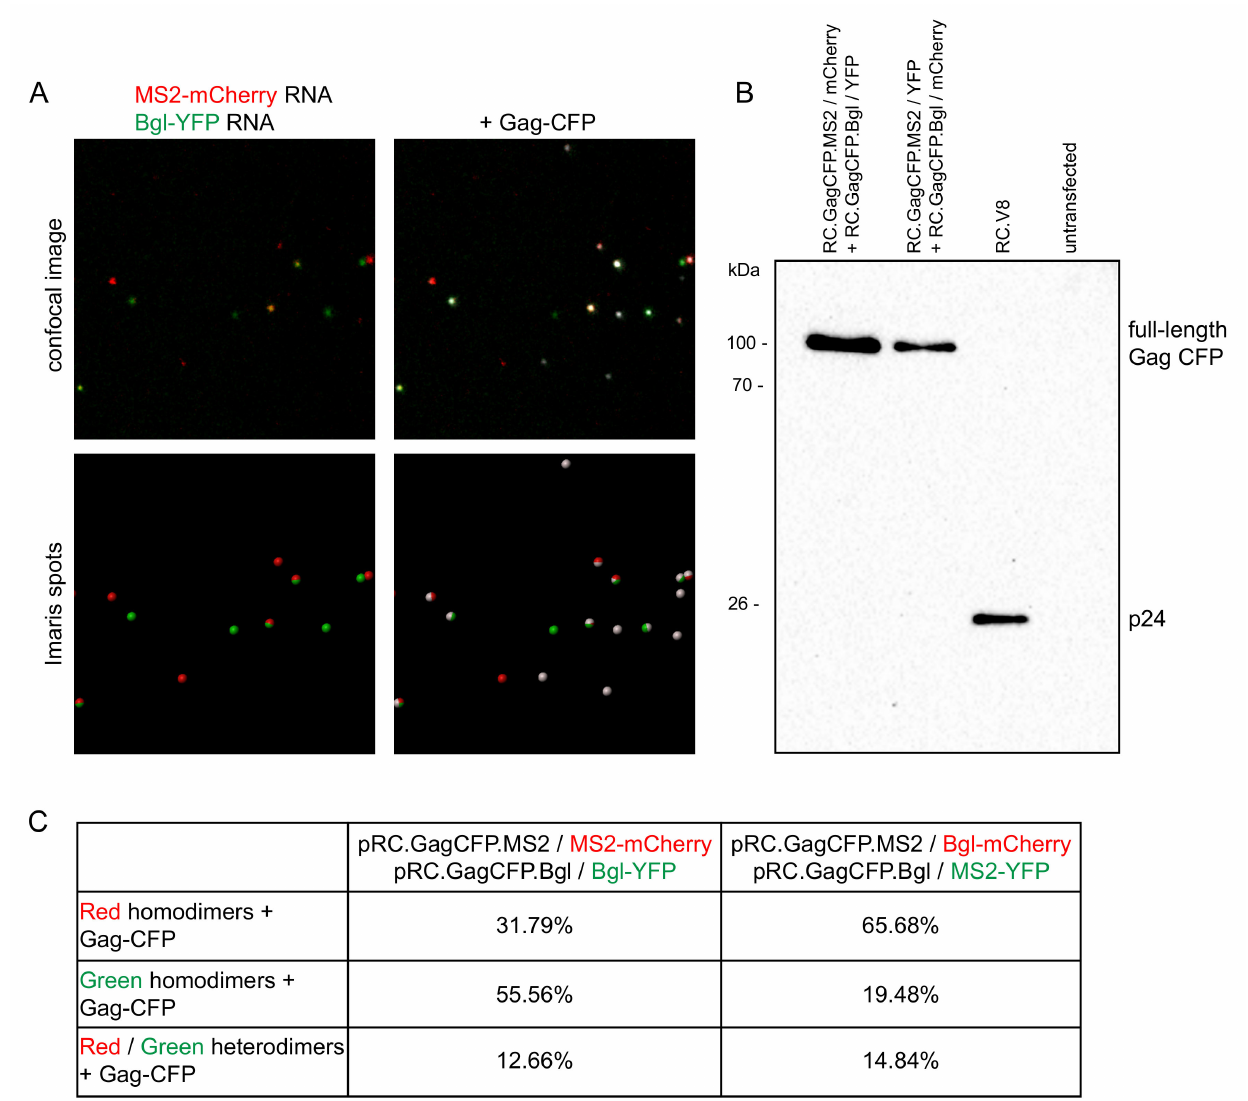
Figure 4. Single virion analysis in RSV shows preferential formation of genome homodimers: ( A ) Confocal microscopy of virions harvested from cell supernatant. QT6 fibroblasts were transiently transfected with proviruses containing MS2 and Bgl RNA stem-loop-containing and their respective fluorophore-labeled coat proteins. Visualized RNA genome foci are considered to be genome dimers, as they were present in virions harvested from the supernatant of transiently transfected cells. The top row shows the confocal microscopy images and the bottom row shows Spots labeled using the Imaris software. Images of virions were obtained using a 63 × objective at 6 × optical zoom; ( B ) Detection of Gag-CFP from virions harvested from cell supernatant expressing loop-containing provirus and their coat proteins by immunoblotting. The Gag-CFP is uncleaved, as expected, since CFP is located between NC and protease. pRC.V8, the wild-type parental proviral construct, which has normal protease activity, was used as a positive control for virus budding; ( C ) Quantitation of the number of genome homodimers and genome heterodimers present within harvested virions. Only RNA genomes that colocalized with Gag-CFP were analyzed, to ensure that RNA was located within a virion. A red-only or green-only focus was considered to be a genome homodimer and a red-green colocalized focus was considered to be a genome heterodimer. The colocalization threshold was set to 0.25 µ m to determine red-green colocalization. To determine colocalization of an RNA focus with a Gag-CFP in virus particles, a colocalization threshold of 0.5 µ m was used. Image histograms were adjusted in the Imaris software to optimize